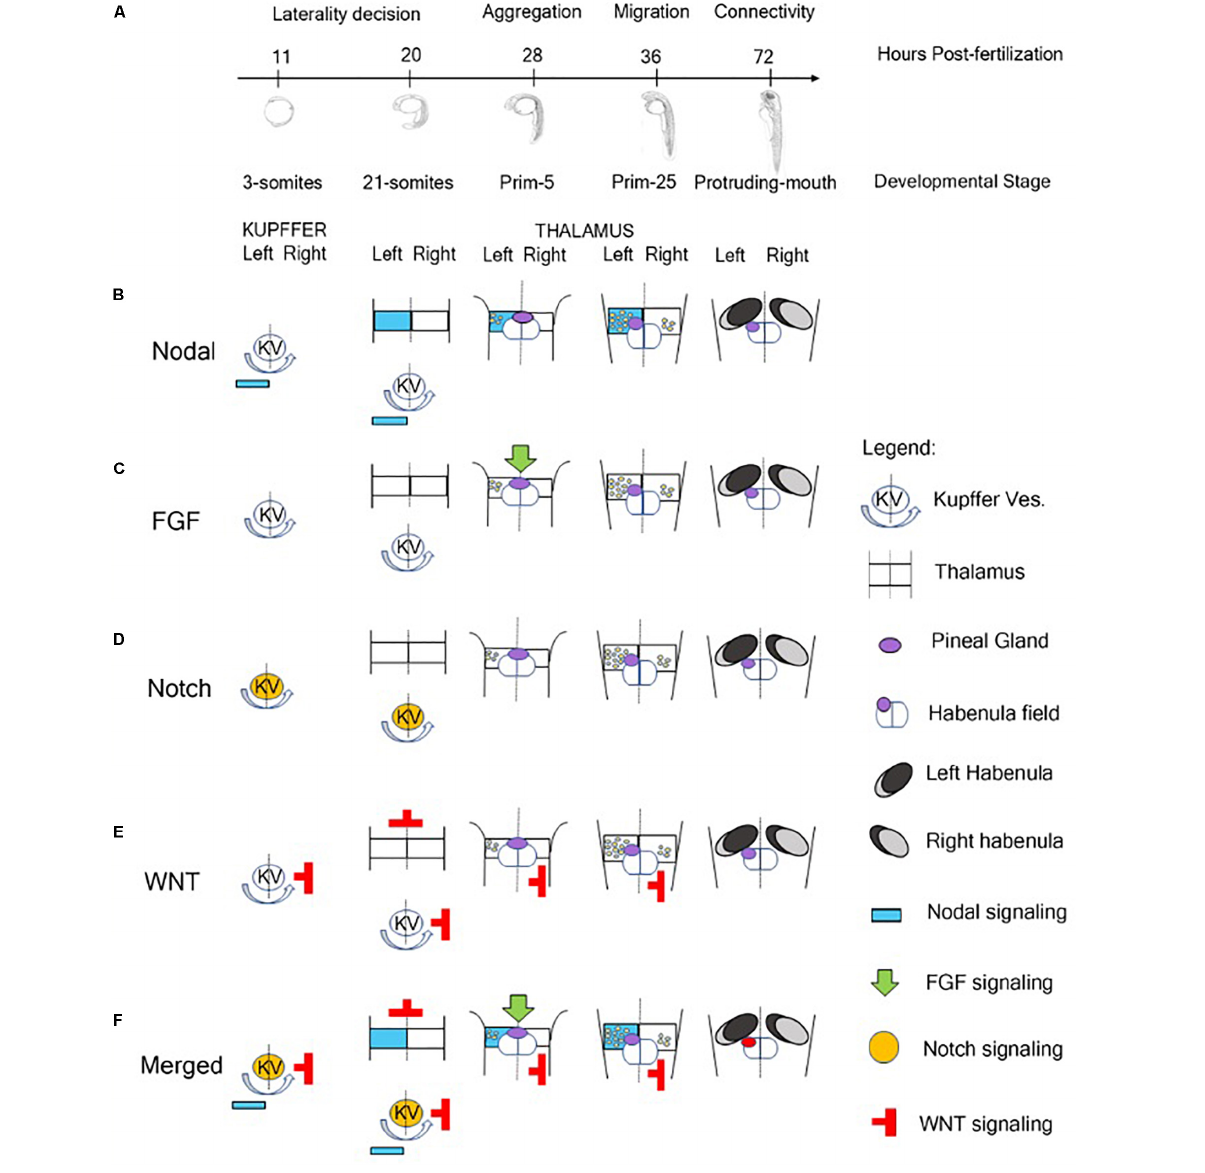
Frontiers in Neuroanatomy |